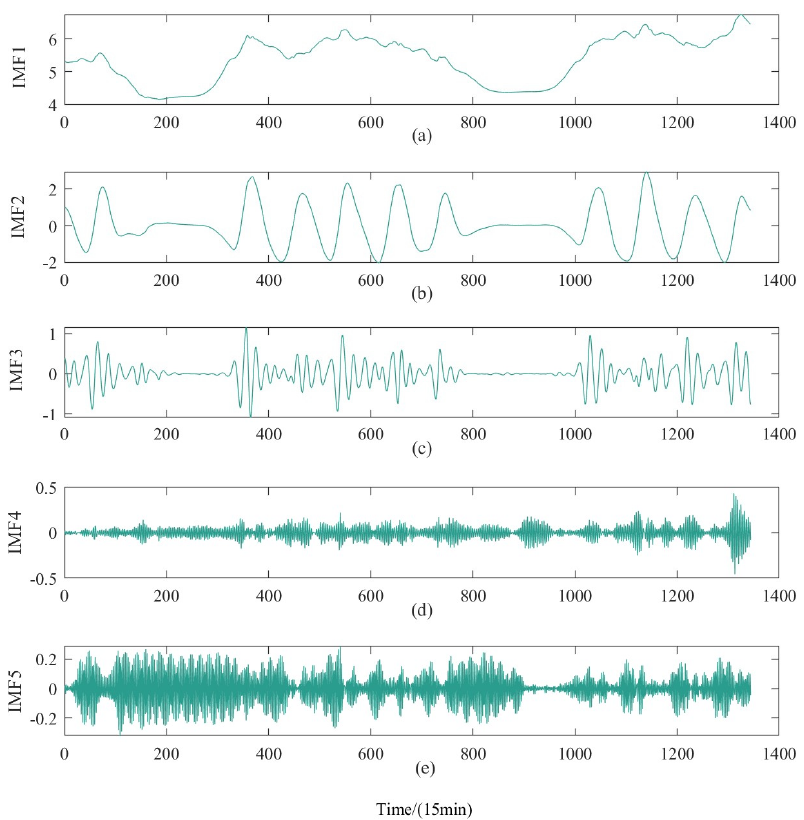
Figure 2. Decomposition results of building power consumption data with VMD. ( a ) IMF1, ( b ) IMF2, ( c ) IMF3, ( d ) IMF4, ( e ) IMF5.